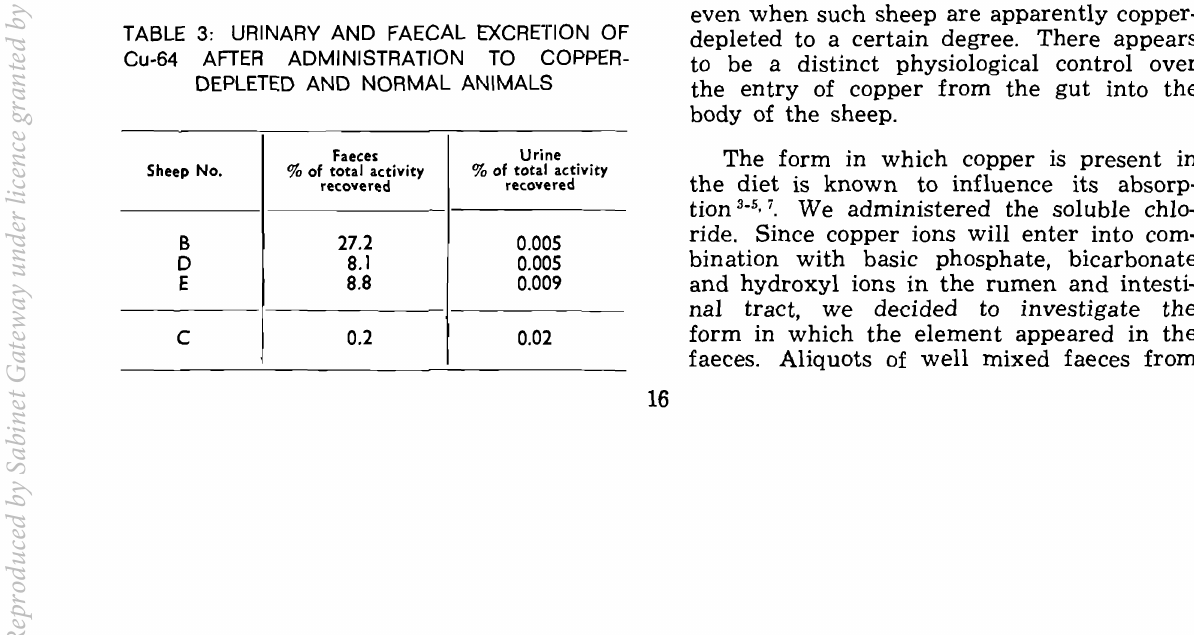
TABLE 3: URINARY AND FAECAL EXCRETION OF Cu-64 AFTER ADMINISTRATION TO COPPER DEPLETED AND NORMAL